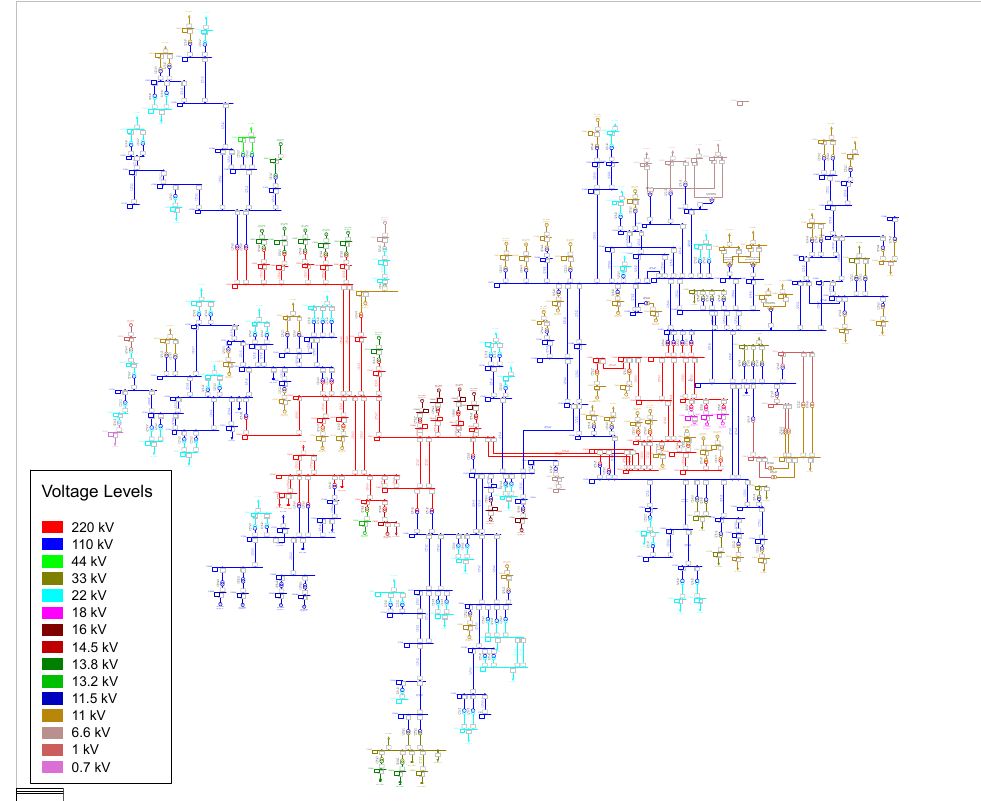
Figure 4. Single line diagram of the Tasmanian network in DIgSILENT